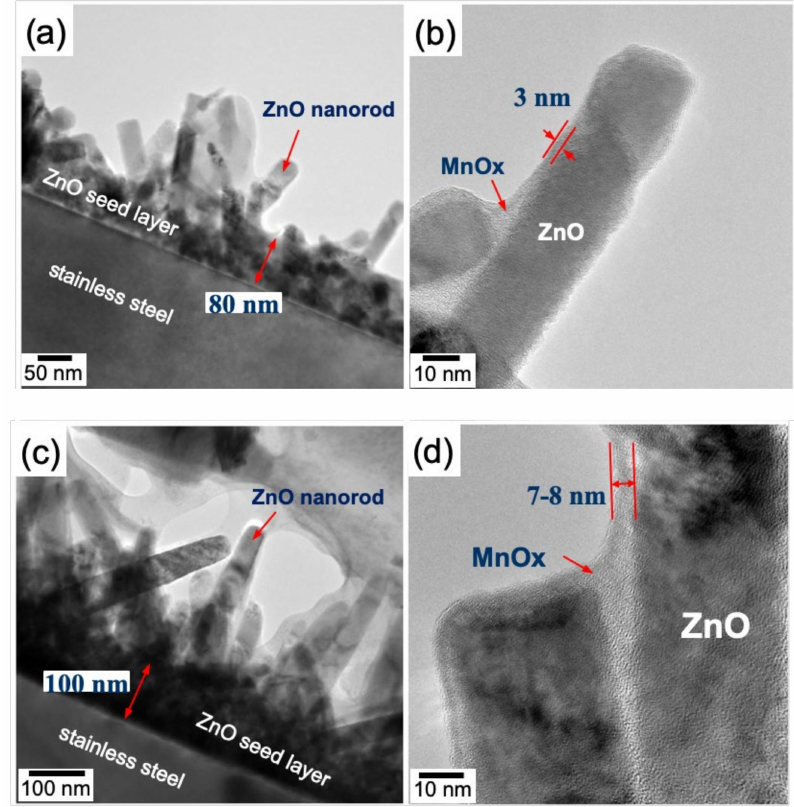
Figure 6. Cross-sectional TEM micrographs of the MnOx-deposited ZnO nanorod at deposition times of ( a , b ) 10 s and ( c , d ) 20 s. The MnOx was coated by anodic deposition in a 0.25 M Mn(CH 3 COO) 2 · 4H 2 O solution at 25 ◦